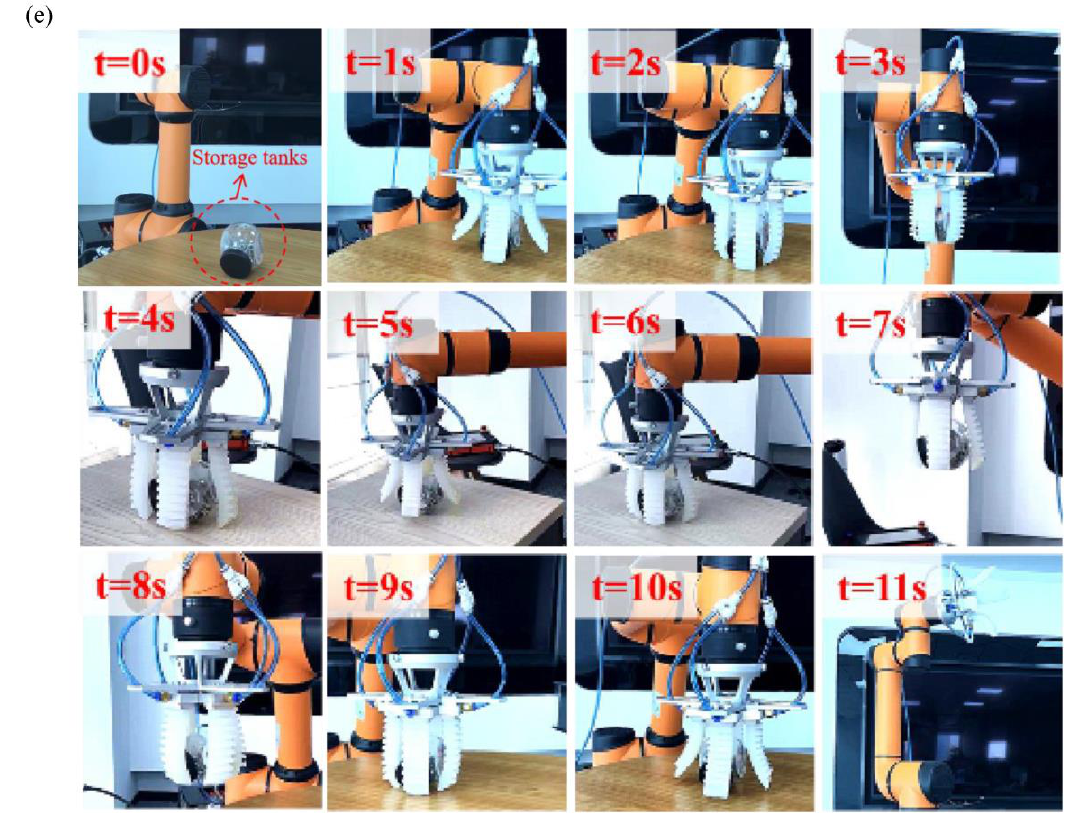
Figure 10. ( a ) Printing process of soft gripper; ( b ) soft gripper dimensioned drawings; ( c ) bending test; ( d ) gripping of different objects; ( e ) experimenting with the gripping process.